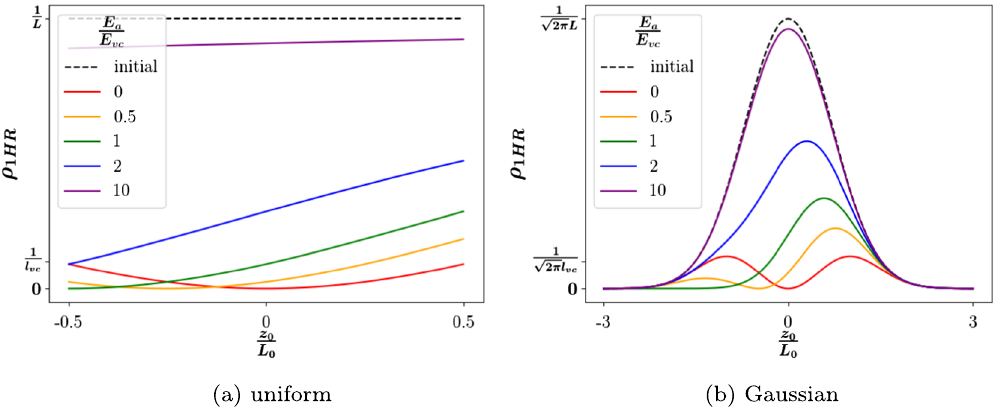
FIG. 10. Theoretical planar symmetric asymptotic distributions (solid lines) plotted against the initial position for various applied Q tot ; 1 fields, measured in multiples of E . The black dotted line indicates the initial distribution. Notice that in both cases, the actual 2 ϵ T 1 ¼ distribution is located at z ð t Þ at time t , but as this has a one-to-one relation with z 0 , we use the initial location for the sake of